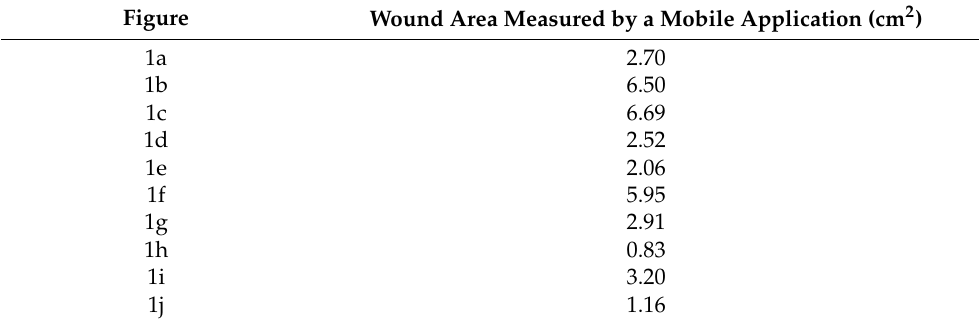
Table 4. Wound area measured by the mobile application.